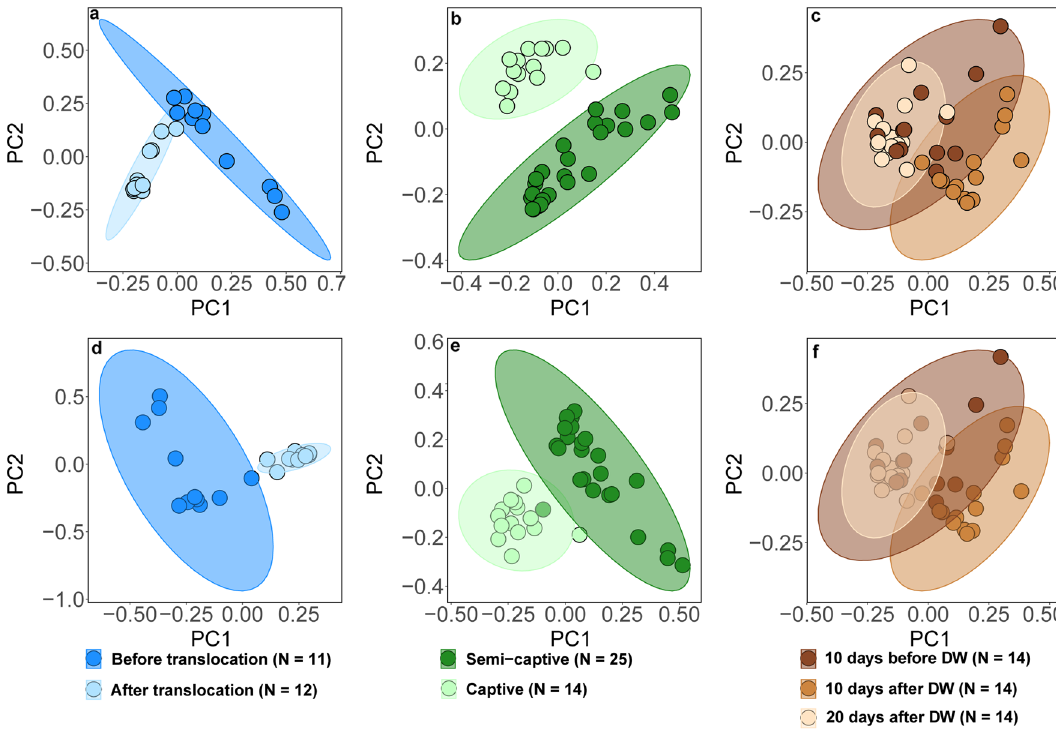
Figure 4. Testing of gut microbiome beta diversity. PCoA plots based on Jaccard ( a–c ) and Bray–Curtis ( d–f ) for samples sequenced using the 16S rRNA gene V3–V4 region. Samples before and after the translocation of elephants are represented in ( a,d) , samples from individuals living in semi-captivity and in captivity were examined and represented in ( b,e) , while ( c,f) show the effect of deworming (DW) on diversity.